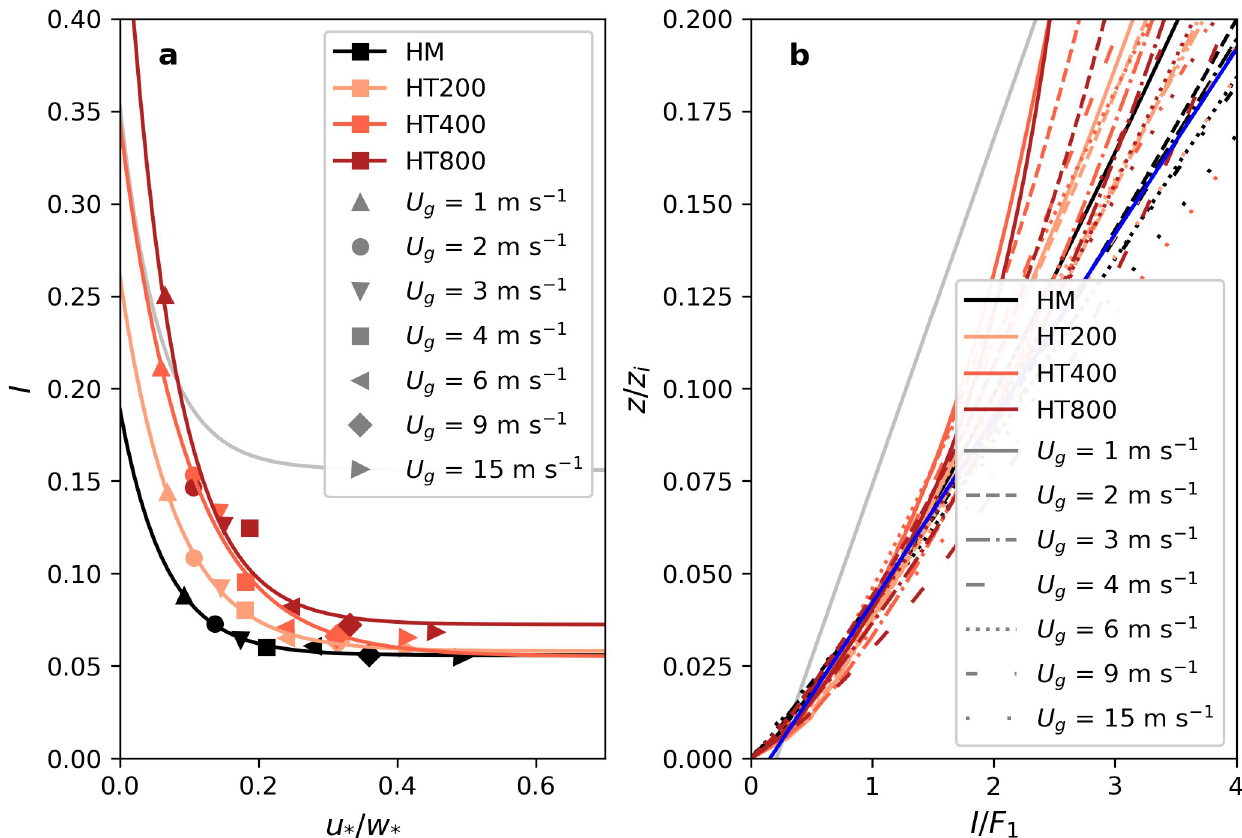
Fig 2. Imbalance ratios as a function of the atmospheric stability. Panel a shows the imbalance ratio I at 0.04 z/z i as a function of the stability parameter u � /w � . The four simulation sets are represented by different colors. For each simulation set, a separate fit of the scaling function F 1 was performed, resulting in Eq 11 with different fitting parameters shown in Table 1. The atmospheric stability is steered by changes in U grey line shows the fit obtained by De Roo et al. [58] (Eq 3) for comparison. Panel b shows the vertical profiles of the imbalance normalized with the four fits of F 1 (Eq 11), respectively. The blue line shows the fitted scaling function F 2,R (Eq 12). Again, the respective scaling function derived by De Roo et al. [58] (Eq 4) is shown in grey for